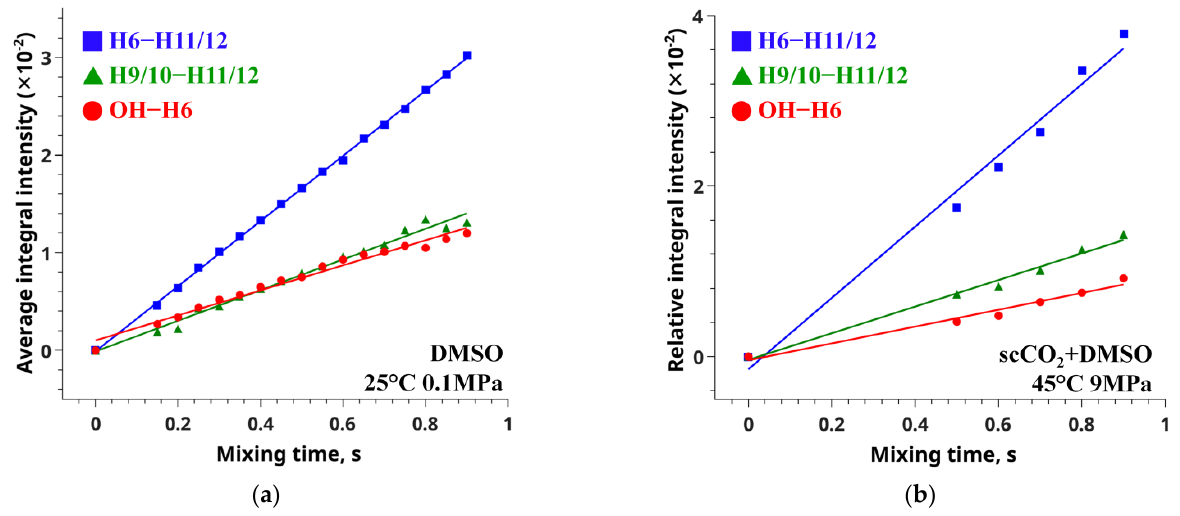
Figure 6. Integral intensity as a function of the mixing time for the conformation-dependent (red and green lines) and reference (blue) distances, obtained by analysis of NOESY spectra measured for MFA in DMSO-d 6 ( a ) and scCO 2 + DMSO-d 6 at 45°, 9 MPa ( b ).